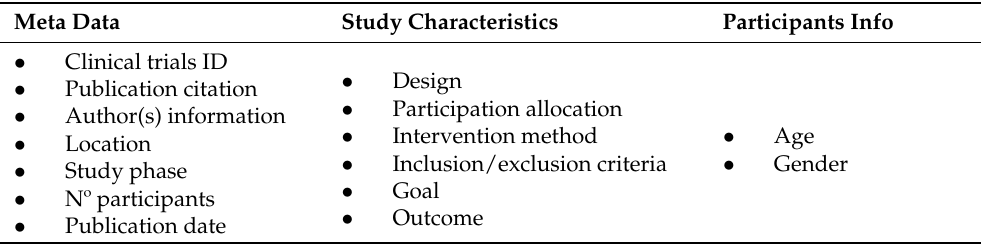
Table 2. Study parameters extracted for data